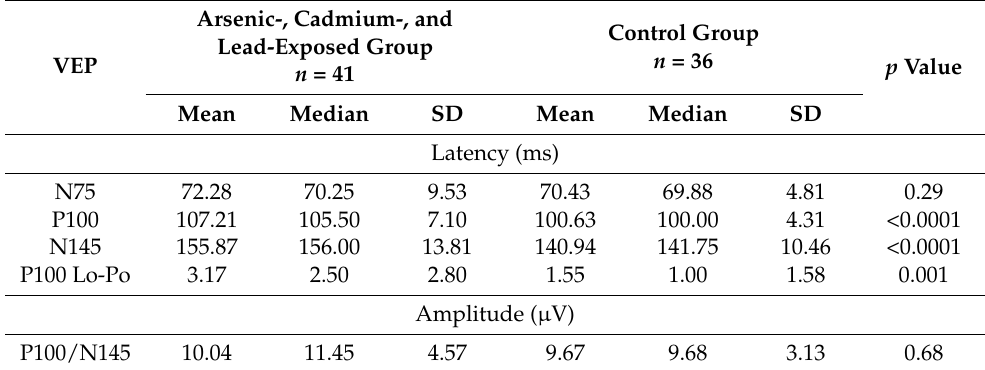
Table 3. Mean values of the latency (ms) and amplitude ( µ V) of visual evoked potential VEP parameters in the arsenic-, cadmium-, and lead-exposed group and in the control group.